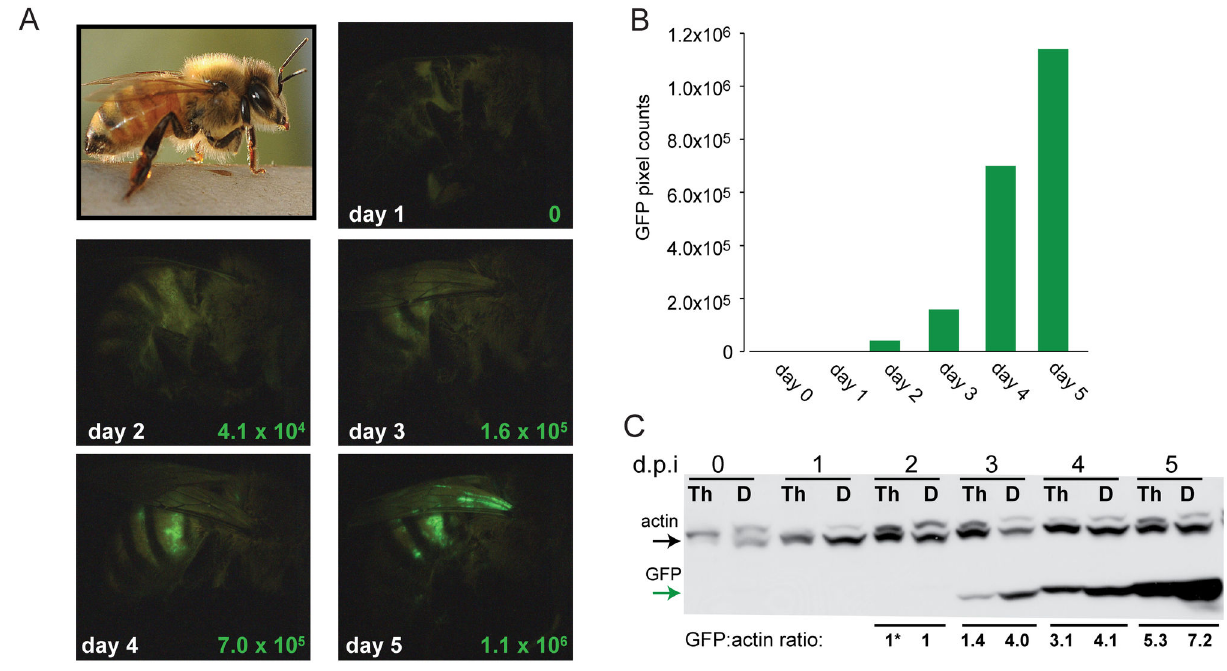
Figure 1. Honey bees are productively infected with a model virus, SINV-GFP. (A) Honey bees were infected with SINV-GFP and fluorescence microscopy revealed increased amounts of GFP each day post-injection (d.p.i.) (GFP pixel counts quantified using ImageJ in lower right corner of each image) and represented graphically in (B). (C) SINV-GFP was detected in honey bee protein lysates from the injection site, thorax (Th), and distal sites (D; head and abdomen) each d.p.i. by Western blot analysis using α-GFP (green lower arrow) and a-actin (top arrow) antibodies. Western blot bands were quantified using ImageJ and the GFP:actin ratio was normalized to 1* at day 2